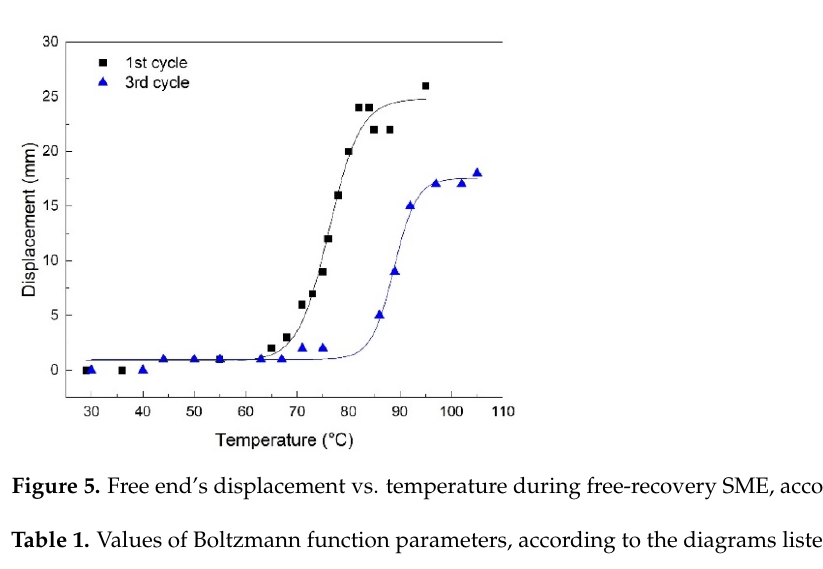
1st Cycle 3rd Cycle Parameter Value Standard Error Value Standard Error